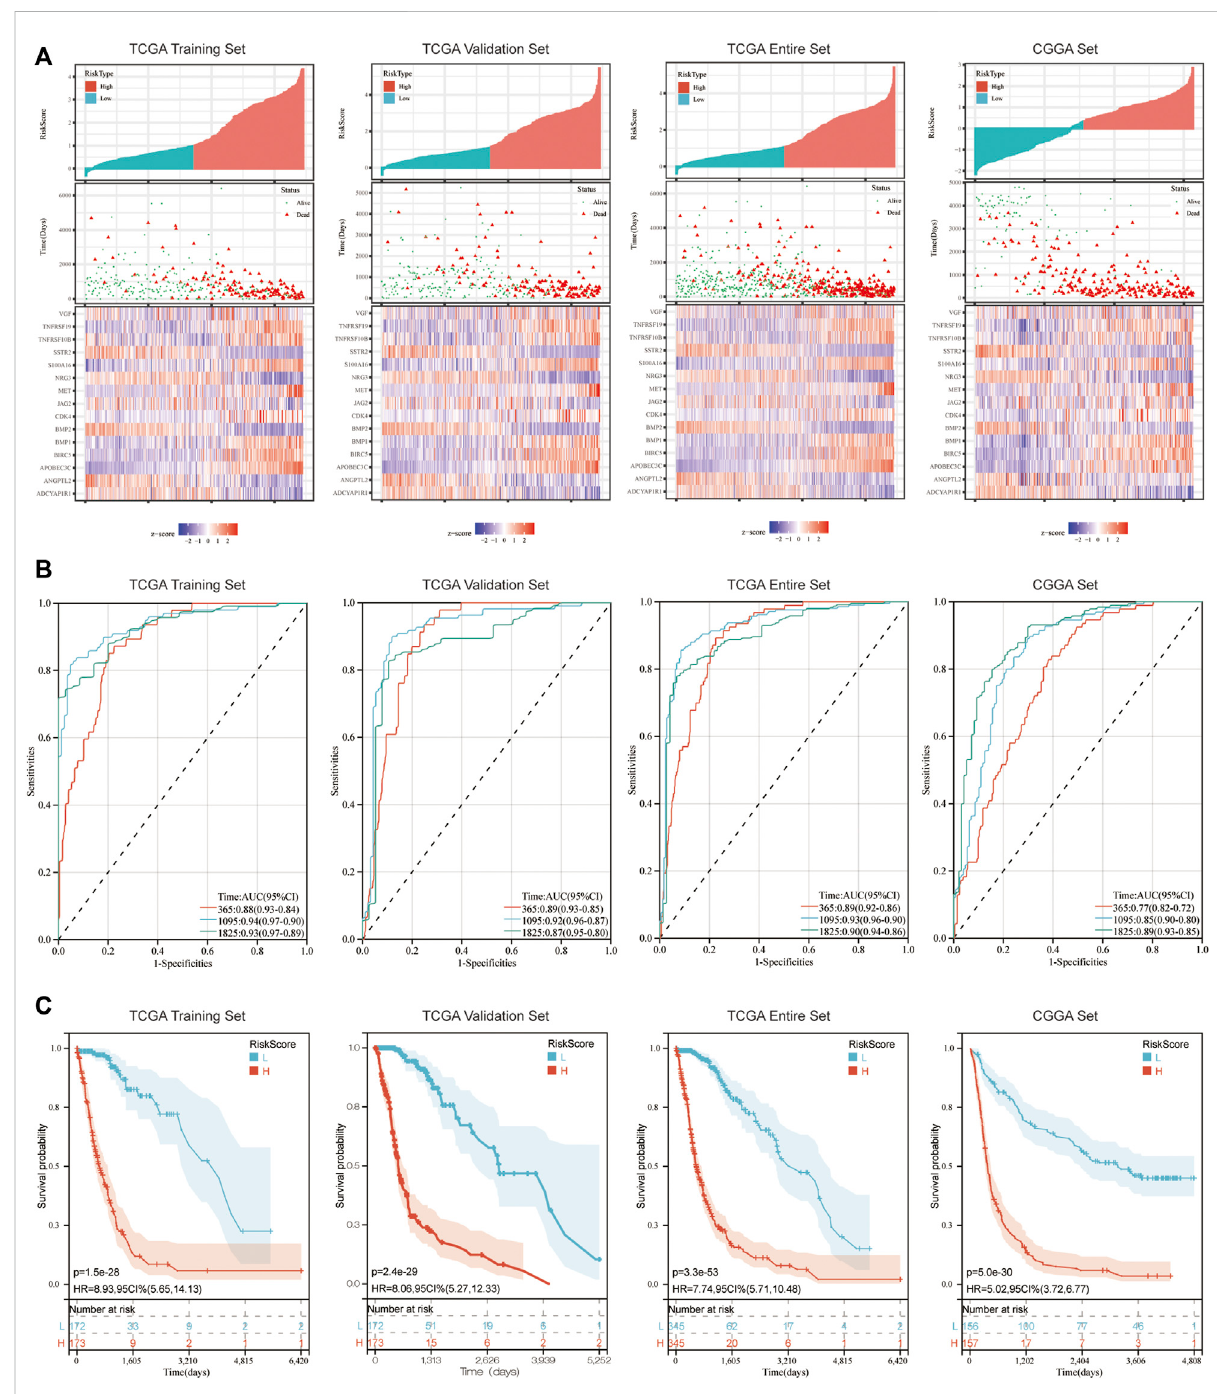
FIGURE 2 Immune-relatedsignatureeffectivelypredictstheprognosisofpatientswithglioma. (A) Riskscoredistribution,survivalstatusandexpressionof 15 hub genes for glioma in low-risk and high-risk groups. (B) 1, 3 and 5-year ROC curve analyses. ROC, receiver operating characteristic. (C) K-M survival curve